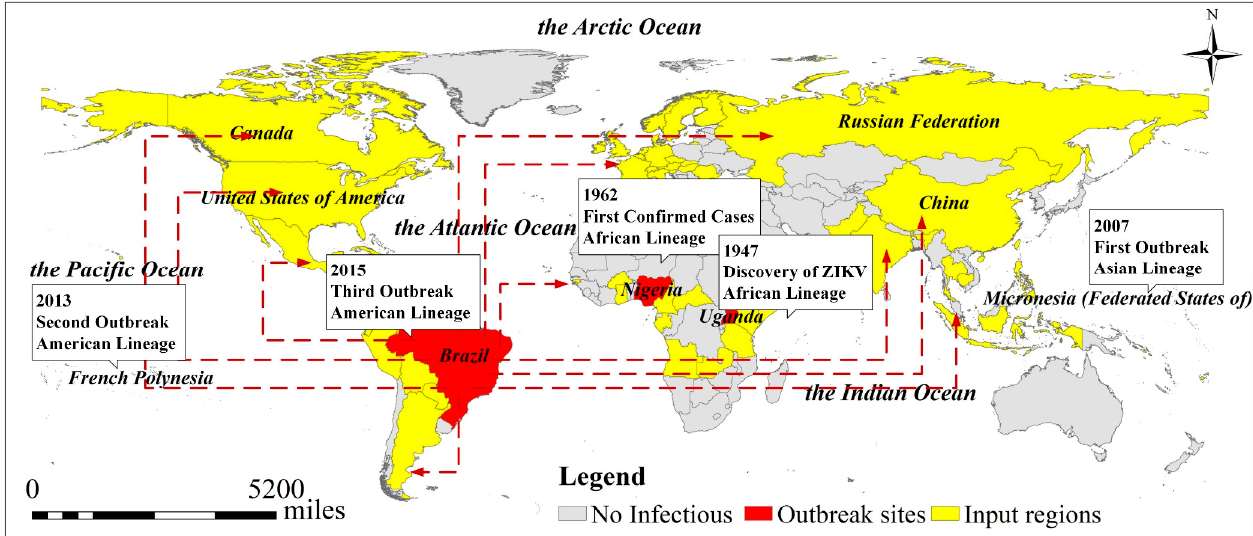
Figure 7. ZIKV outbreak sites and its transmission route in 2016. Yellow represents the input regions, and red represents the outbreak sites. The arrows indicate the ZIKV transmission routes. Information in the box is the outbreak time, outbreak times of ZIKV and virus type [38].